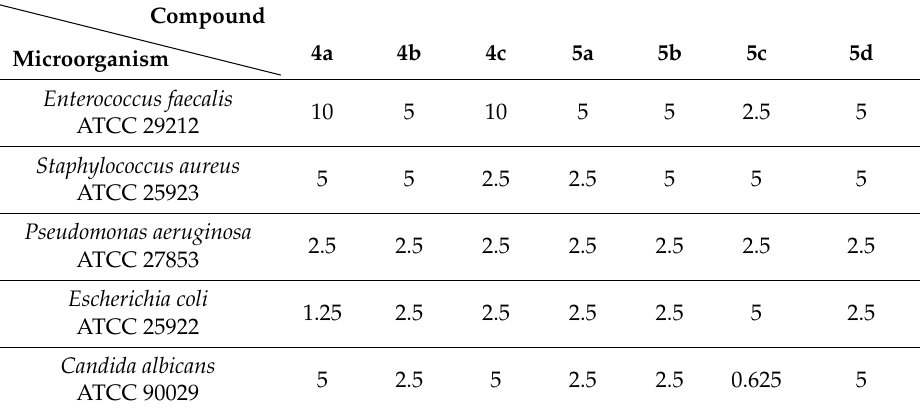
Table 1. MIC (mg / mL) values for the compounds 4a – c , 5a –